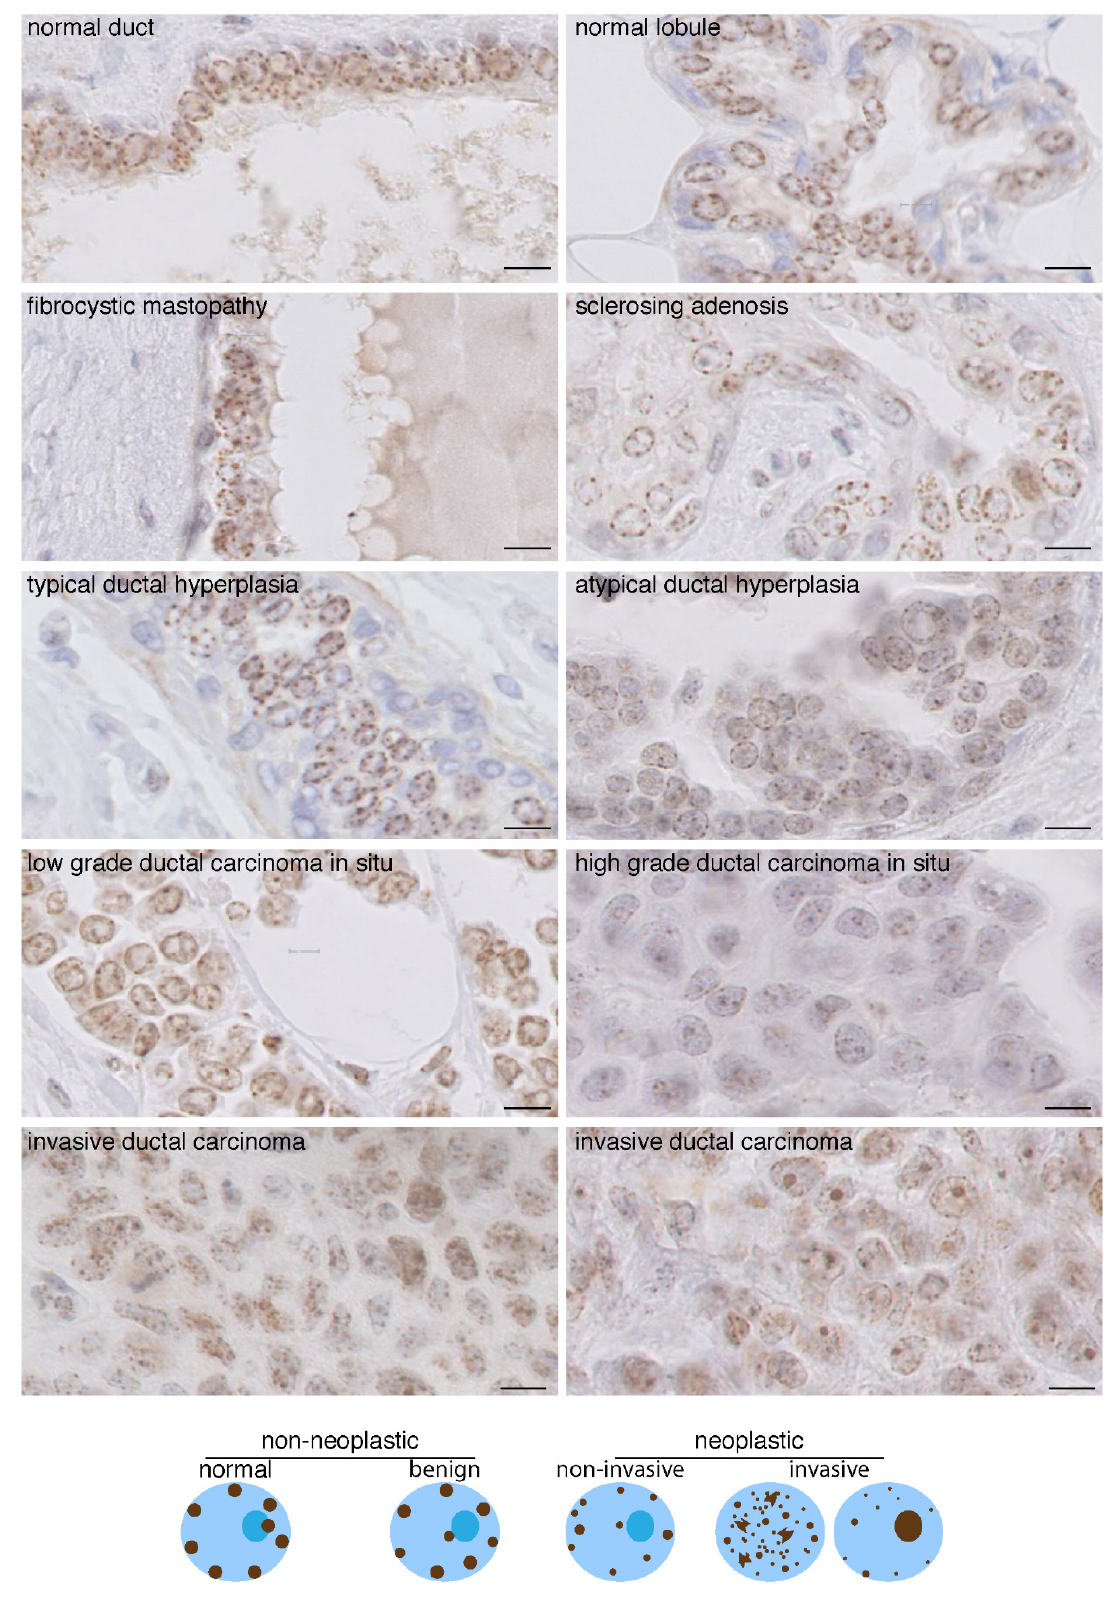
Figure 3. CENP-A localization patterns in breast lesions. Top: CENP-A staining by IHC in breast tissues as indicated. Invasive ductal carcinoma displaying CENP-A foci localized only inside the nuclear space ( left ) and a few remaining at the nuclear periphery ( right ) are shown. Scale bar is 10 µ m. Bottom: scheme depicting the